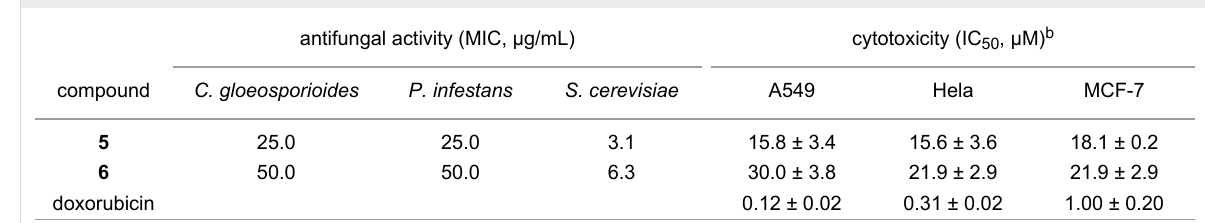
Table 3: Antifungal activity and cytotoxicity of 1 – 6 a